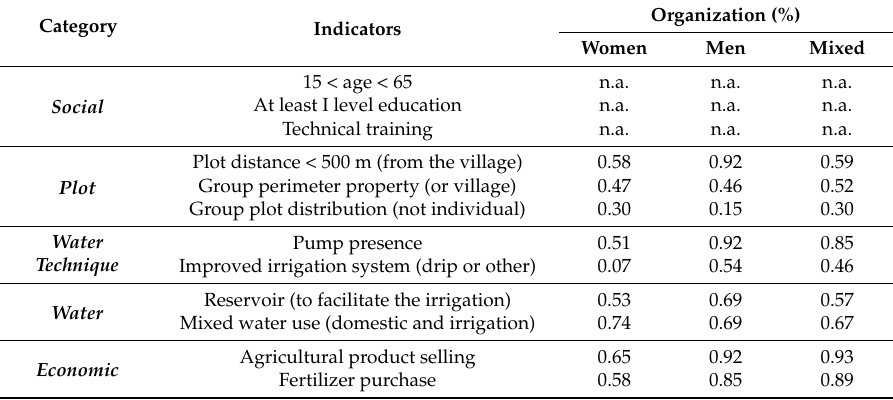
Table 4. The indicators values, divided by women, men and mixed farmer